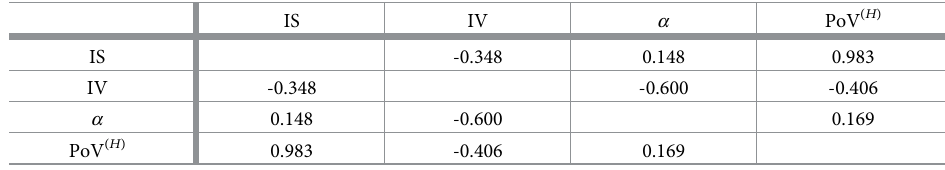
Table 2. Pearson’s correlation coefficients between pairs of statistical measures for participants with advanced dementia (combined non-intervention and intervention groups). IS IV